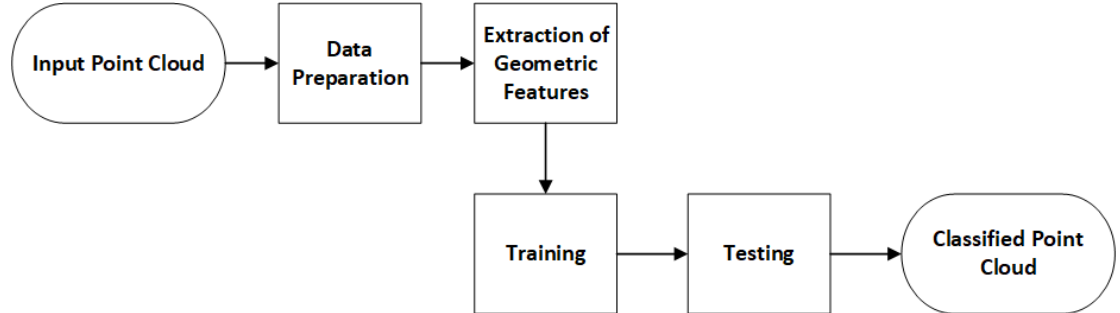
Figure 1. Flowchart of applied approach in the study.